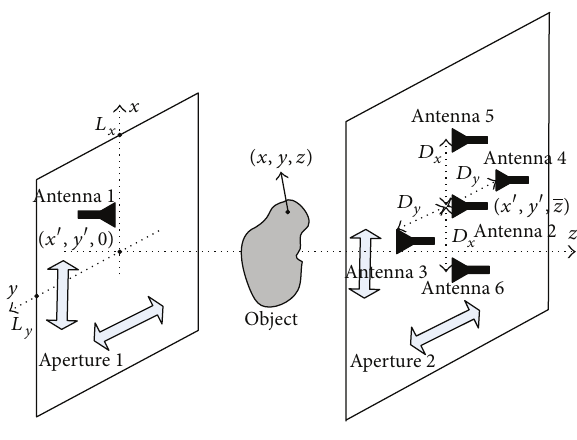
Figure 3: Proposed 3D microwave holography setup using forward- scattered waves only. Antenna 1 illuminates the object while anten- nas 2 to 6 receive the scattered waves. The grey thick arrows show the directions of the